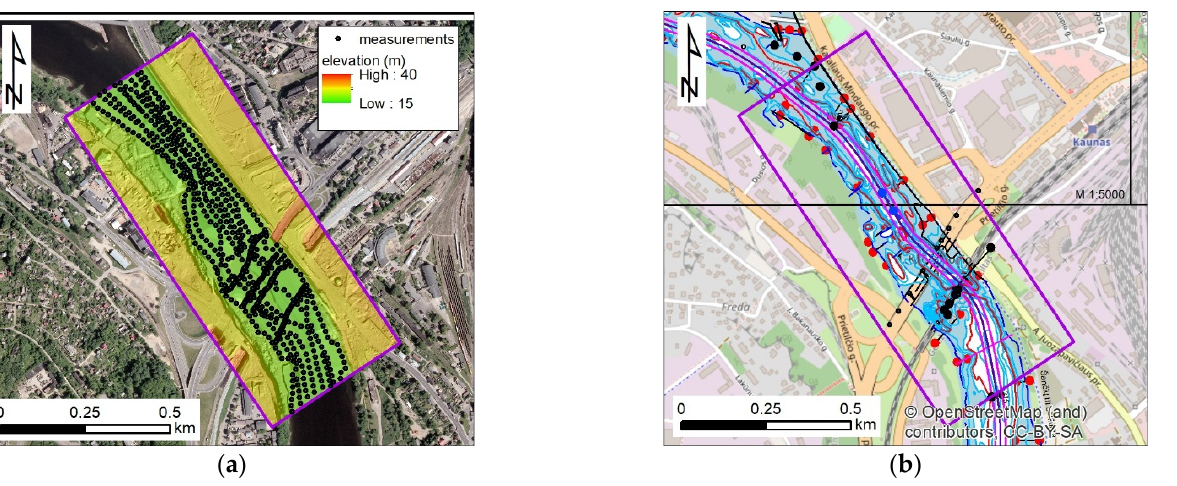
Figure 3. The maps and design of the investigated bridge: ( a ) ortophotomap with digital terrain model (DTM) of the bridge and measurements of the bathymetry, ( b ) design in CAD format converted to ArcGIS with OpenStreetMap in the background.